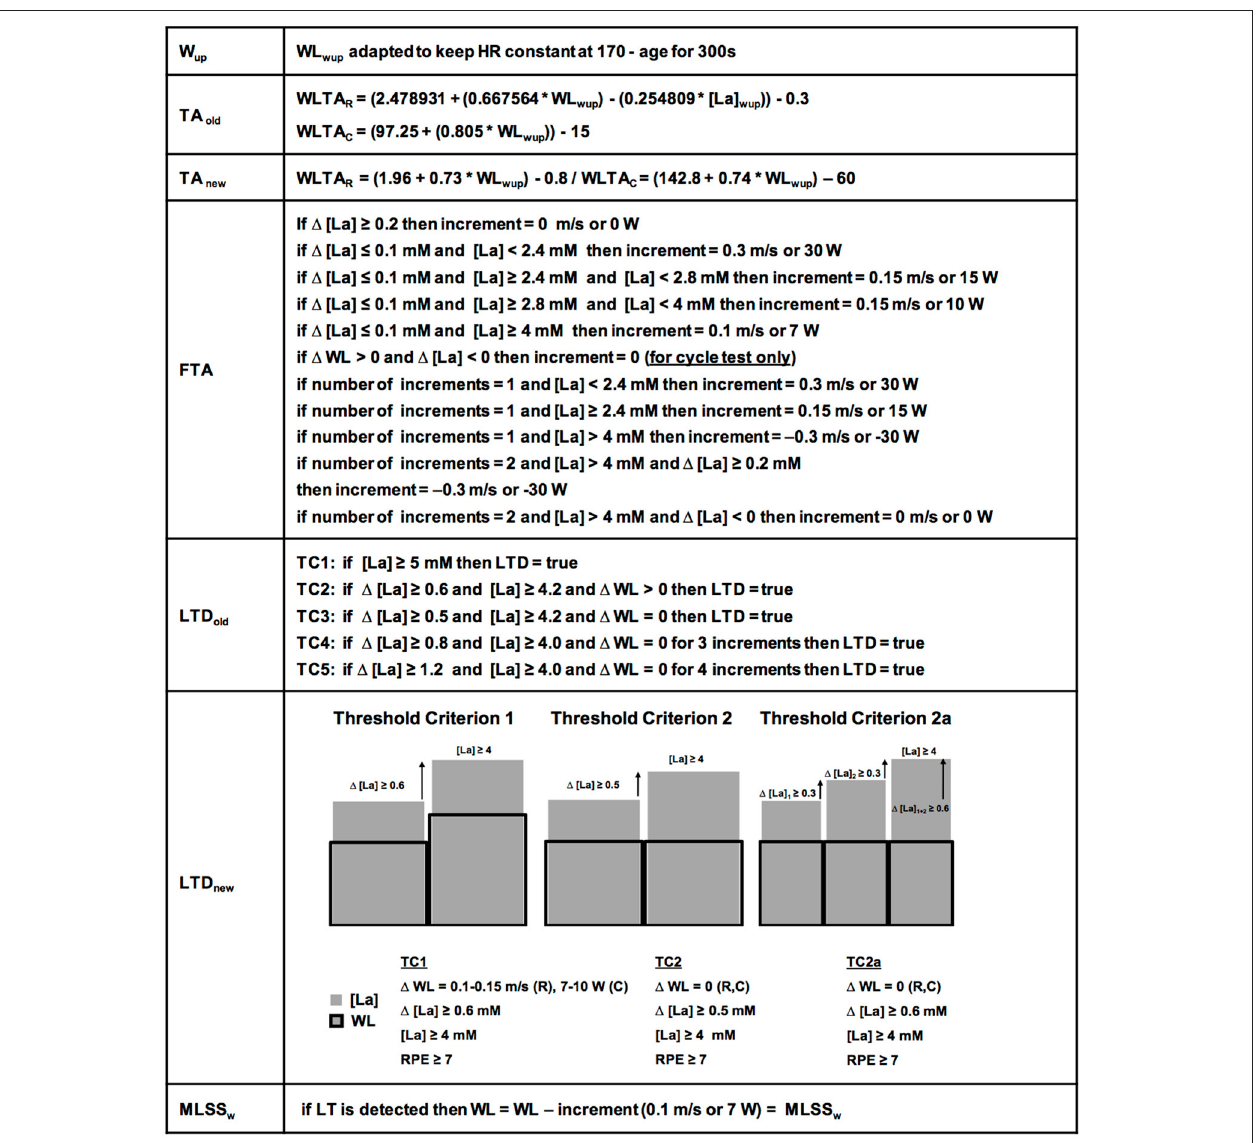
FIGURE 1 | Detailed ILT-Test algorithms. The warm-up (W up ) workload (WL) was kept constant automatically. The initially used threshold adaptation (TA old ) algorithm (for determination of the first workload increment after the W up ), has been continuously developed into the currently used threshold adaptation algorithm (TA new ). The fine threshold adjustment (FTA) was depending on the number of steps and the lactate concentration after every step. Note the specific criteria for ILT-Tests on the bicycle ergometer for the FTA. The first identified threshold criteria (TCs) for determination of the lactate threshold (LTD old ), were constantly verified and developed into the actual TCs 1, 2, and 2a (LTD new ). After lactate threshold (LT) detection, the arterial lactate concentration [LA] increase stopped after a slight workload reduction. HR, heart rate; MLSS W , maximal lactate steady state workload; RPE, rating of perceived exertion; WLTA R , workload threshold adaptation running; WLTA c , workload threshold adaptation cycling.